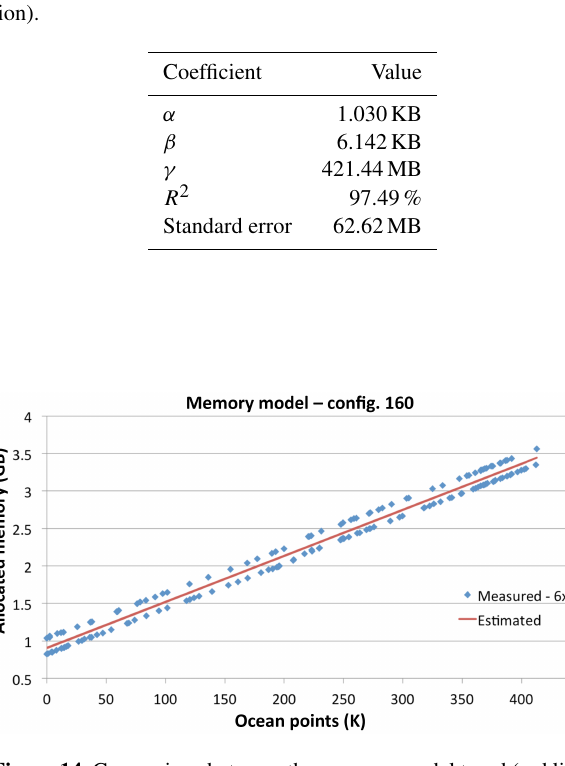
Figure 14. Comparison between the memory model trend (red line) and the experimental values (blue line) for a reference configuration on 160 processes. The decomposition is made up of 6 × 29 subdo- mains, where 14 of them are with land points only.